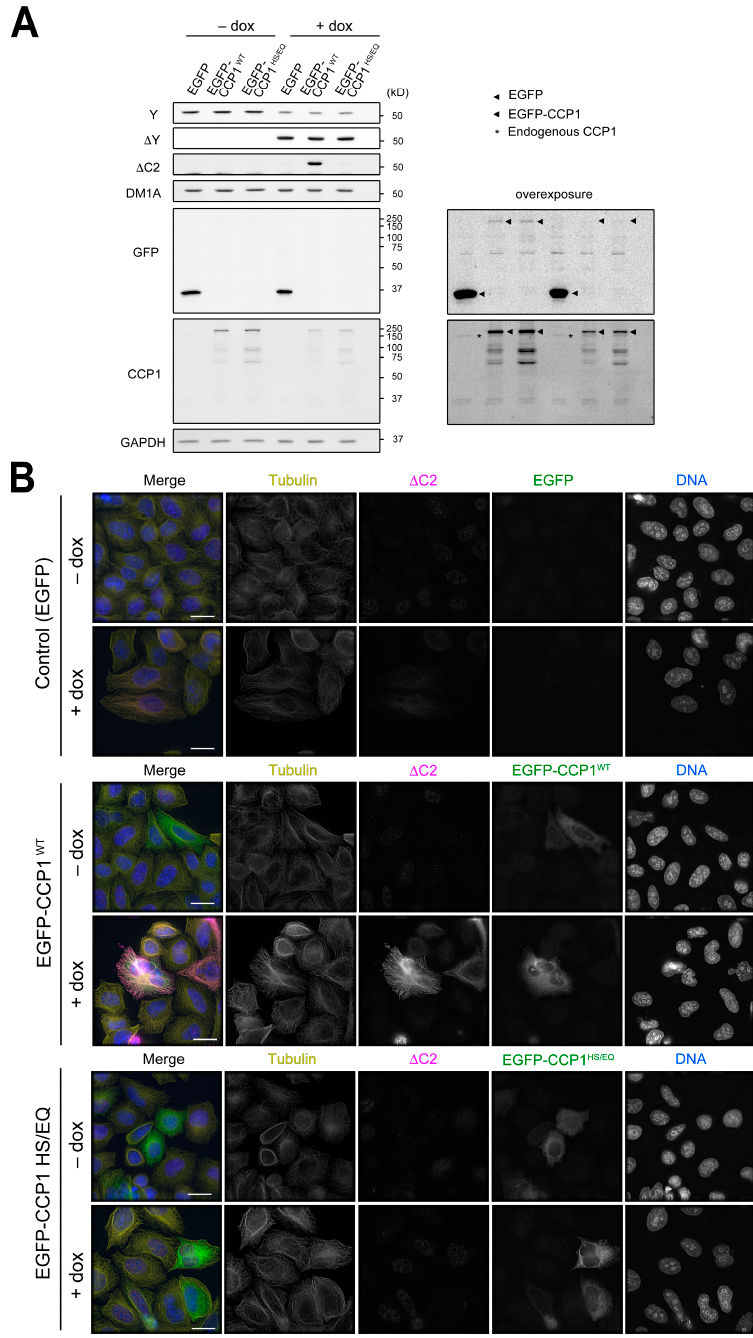
Figure 5. CCP1 uses ∆ Y- α -tubulin as a substrate to generate ∆ C2- α -tubulin in cells. ( A , B ) Detection of ∆ C2- α -tubulin in HeLa cells expressing VASH1-SVBP in a doxycycline dependent manner by immunoblotting of cell lysates ( A ) and immunofluorescence ( B ). In merged images in ( B ), total α - tubulin (DM1A staining) is shown in yellow, ∆ C2- α -tubulin in magenta, EGFP in green, and DNA (DAPI staining) in blue. Scale bars in ( B ), 20 µm.